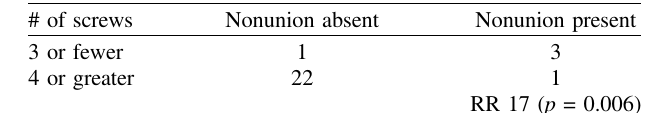
Table 3. Risk of nonunion or loss of fi xation in patients with distal humerus C-type fractures treated with ORIF using 3 or fewer articular screws versus 4 or greater articular screws.